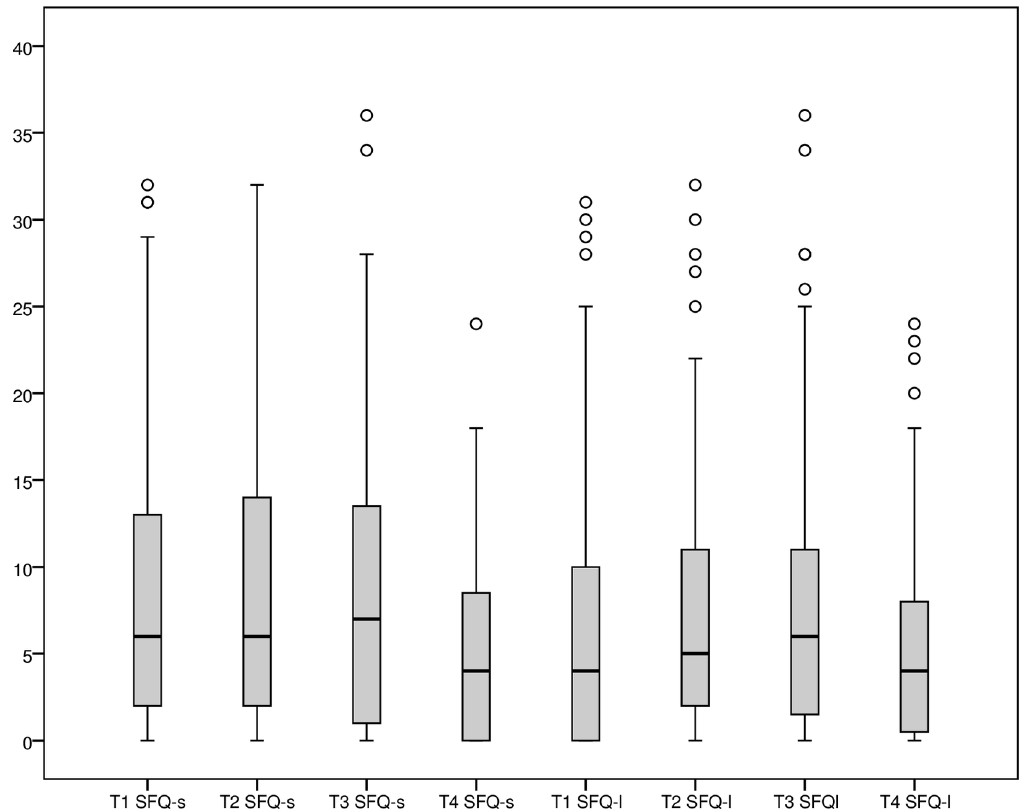
Fig 3. Surgical fear short- and long-term subscales, at time point 1–4. T1-3: all patients, T4: binocular patients only. T1: one week before surgery, T2: the evening before surgery, T3: the morning of the day of surgery, morning, at home, T4: binocular patients, the evening before their second surgery. ˚ indicates